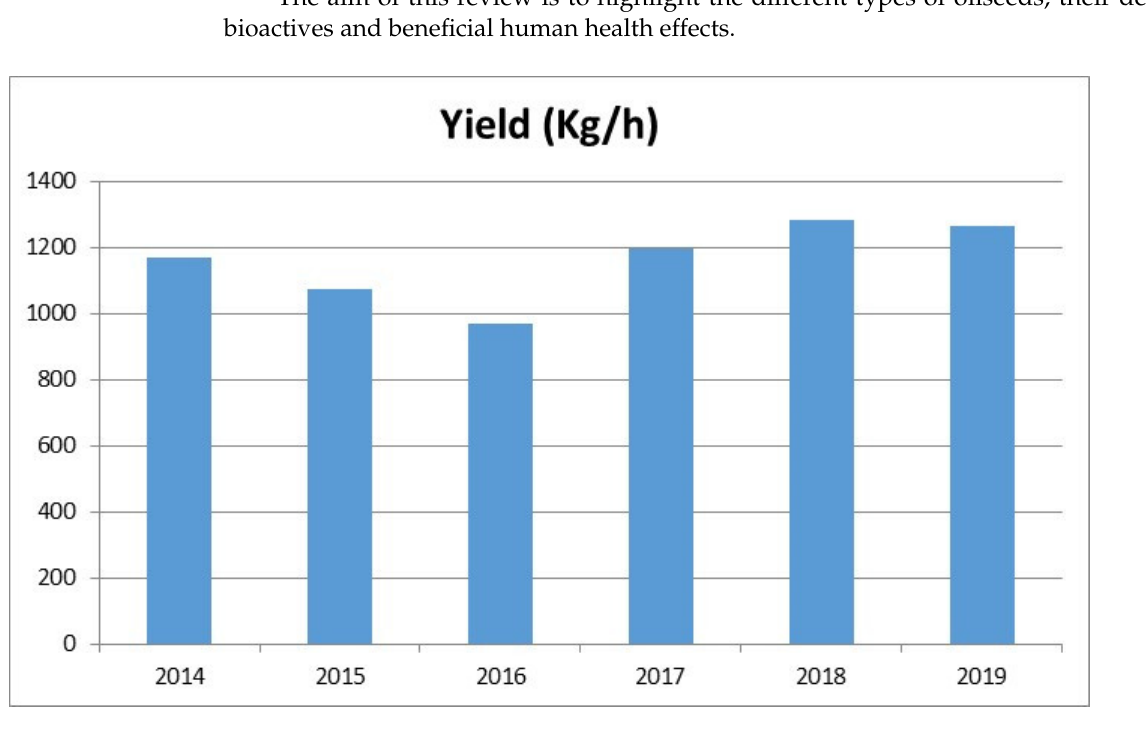
Figure 1. Production scenario of different oilseeds in India in 2020 (adapted from Statista Research Department, https://fr.statista.com/a-propos/notre-engagement-pour-la-recherche (accessed on 2